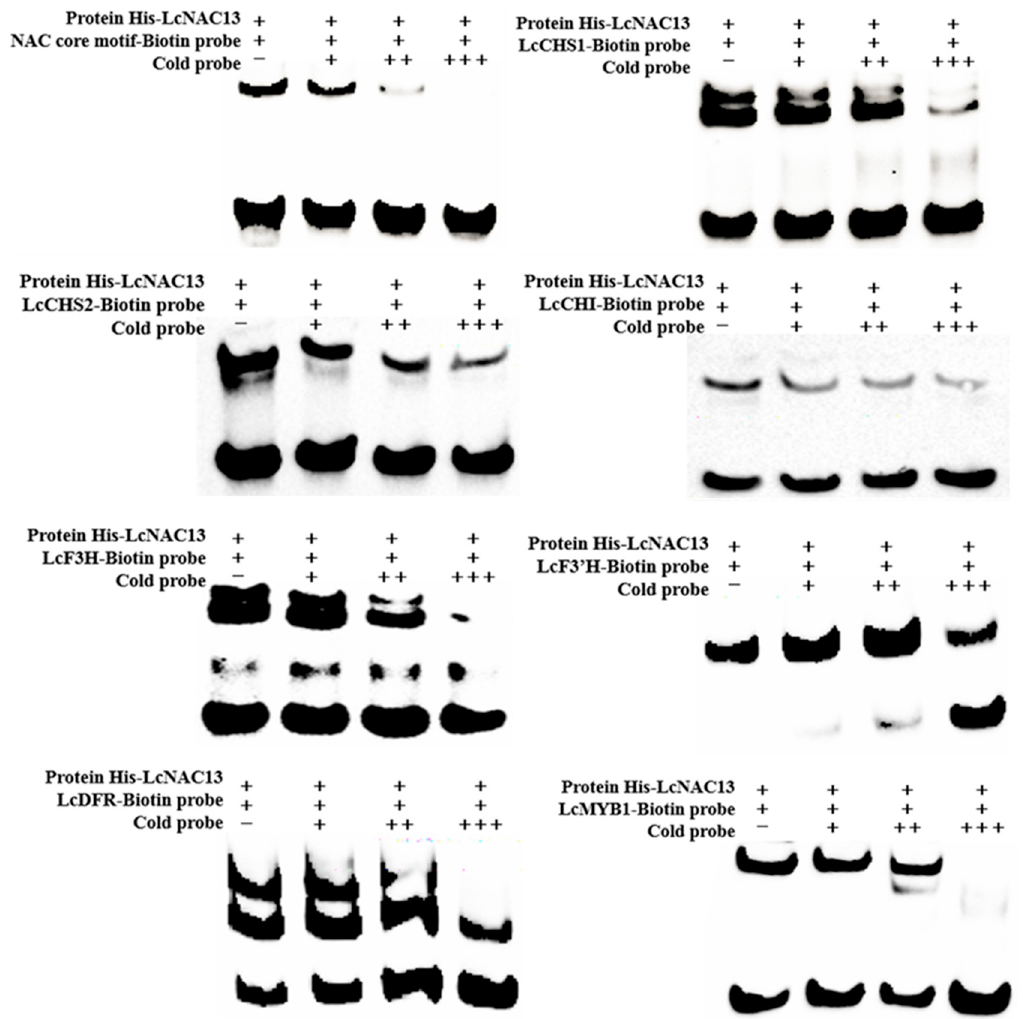
Figure3. Interaction between LcNAC13 and the anthocyanin biosynthesis-related genes in vitro. Purified His-LcNAC13 recombinant proteins were mixed with biotin-labeled probes, and the DNA–protein complexes were separated on 6% native polyacrylamide gels. +, ++, and +++ indicate increasing amounts (100 nM, 10 µ M, and 50 µ M) of unlabeled probes for competition.